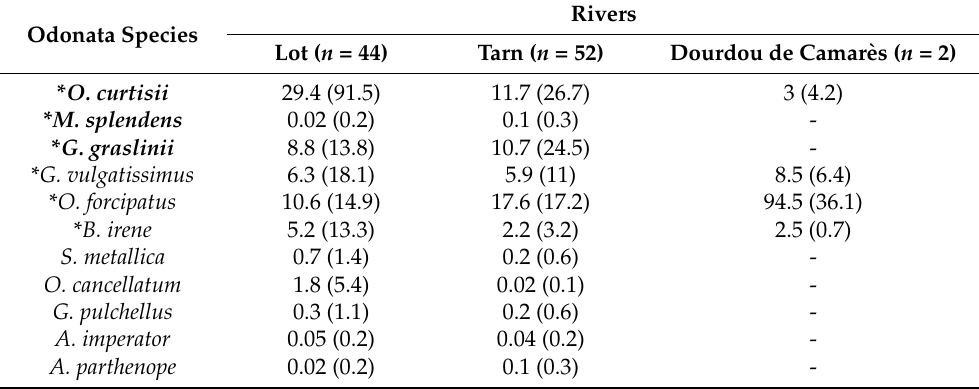
Table 3. Average exuviae density per 100 m long transects obtained during the first plus second visits for each species detected on each river (Lot, Tarn, and Dourdou de Camar è s). The corresponding standard deviations are shown between parentheses. Riverine species according to Dijkstra [10] and Boudot and Grand [33] are indicated by asterisks and this study’s target species (i.e., protected ones) are indicated in